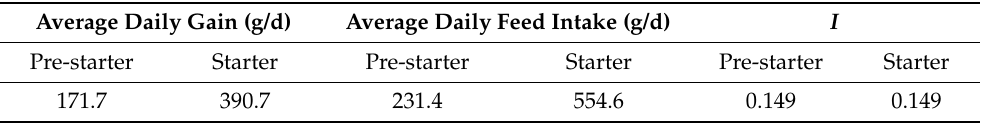
Table 1. Performance parameters and incidence rate ( I ; 1000 piglets-day at risk) of animal losses during the nursery period in the farm for the period before the beginning of the study, when both ZnO and colistin were routinely